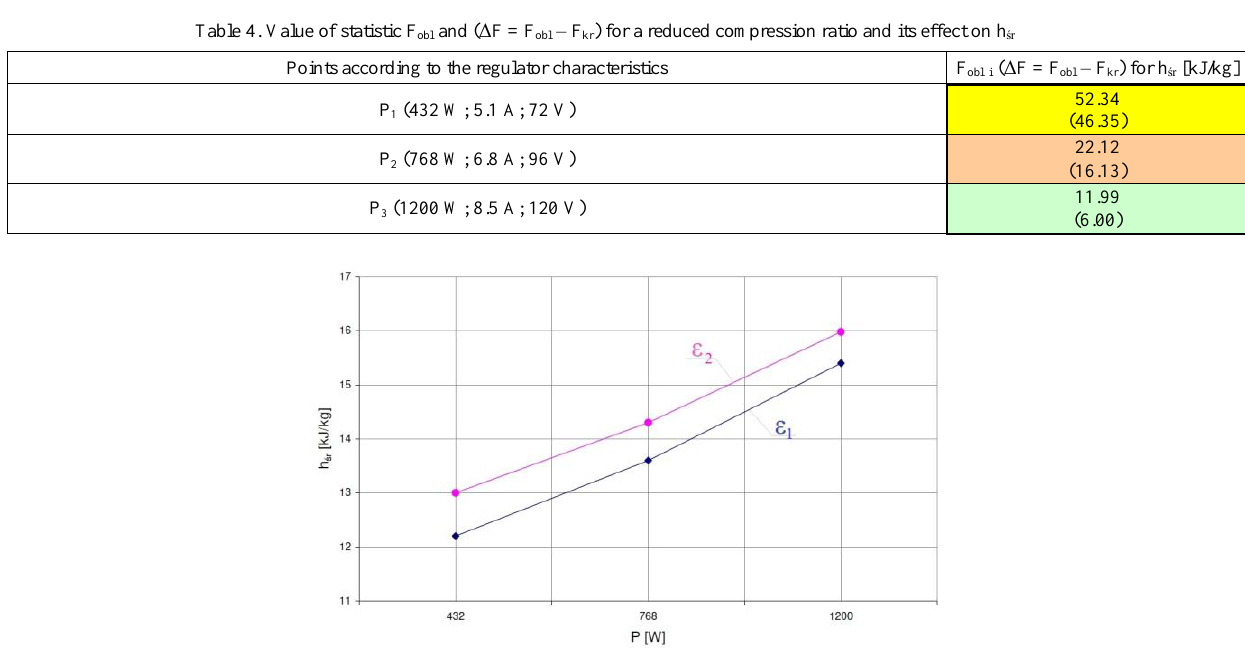
Fig. 6. Effect of the compression ratio (ε) on the value of the average within one cycle of the exhaust gas enthalpy h śr for diesel engine loads according to the regulator